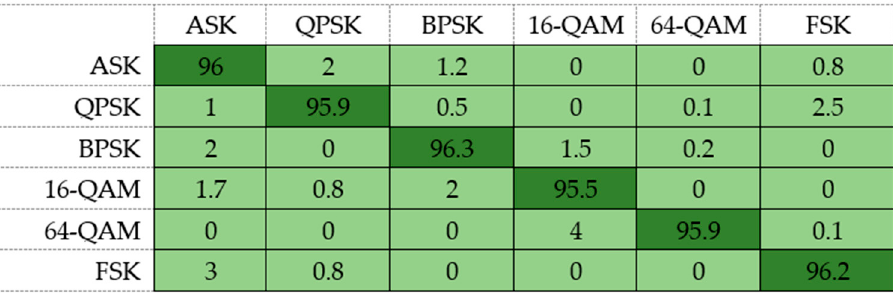
Figure 13. Comparison of precision (Scenario 1).